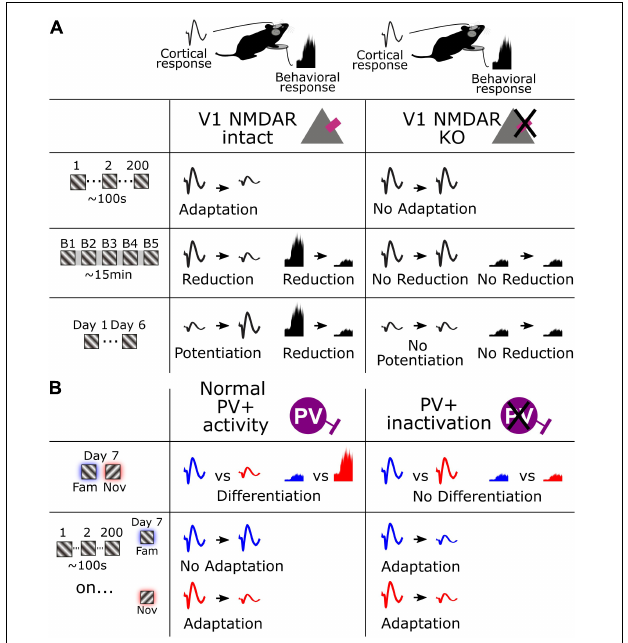
FIGURE 6 | Schematic summarizing fundamental cortical and behavioral changes across multiple timescales. (A) Cortical and behavioral changes over seconds, minutes, and days (left), and the result of V1 NMDAR KO on these changes. (B) Cortical and behavioral changes in response to a familiar and novel stimulus and the associated adaptation (left), and the result of PV+ interneuron inactivation on these changes.